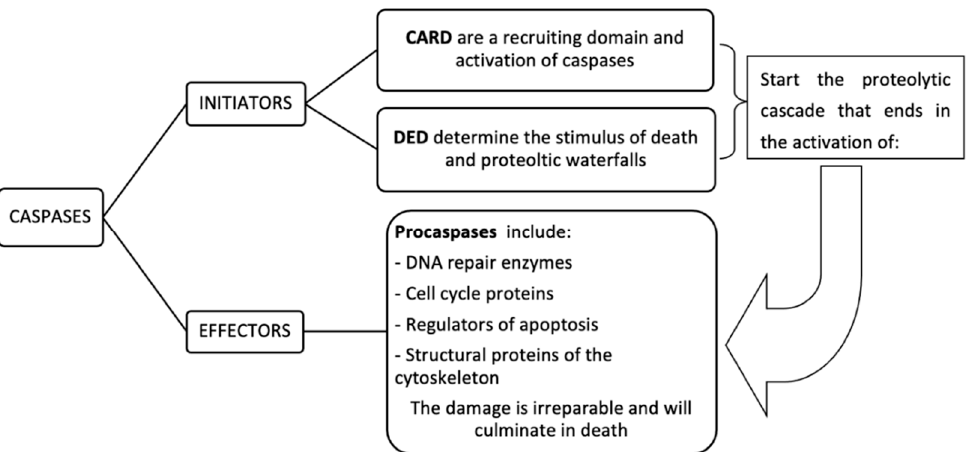
Figure 4. Types of caspases: classification and main functions. Initiator caspases, including CARD [17] and DED [18], and effector caspases, including procaspases, as well as their functions are represented. CARD, caspase activation and recruitment domain; DED, death effector domain.